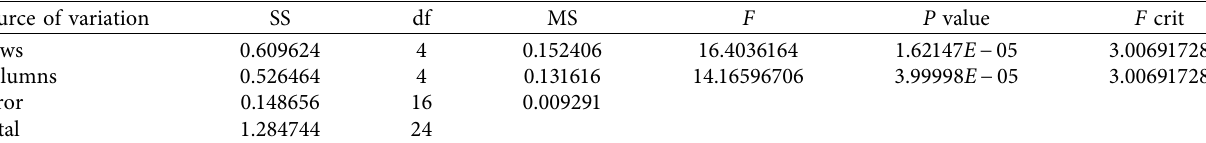
Table 8: Results of ANOVA.